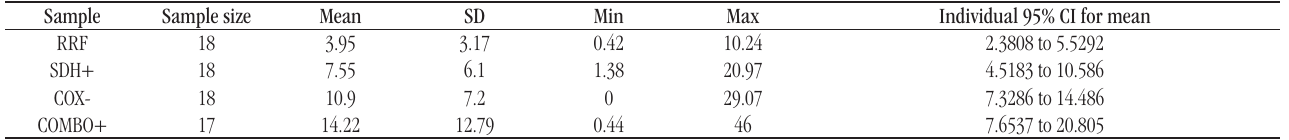
taBLE 2 − One-way Anova for the four quantitative events (%)